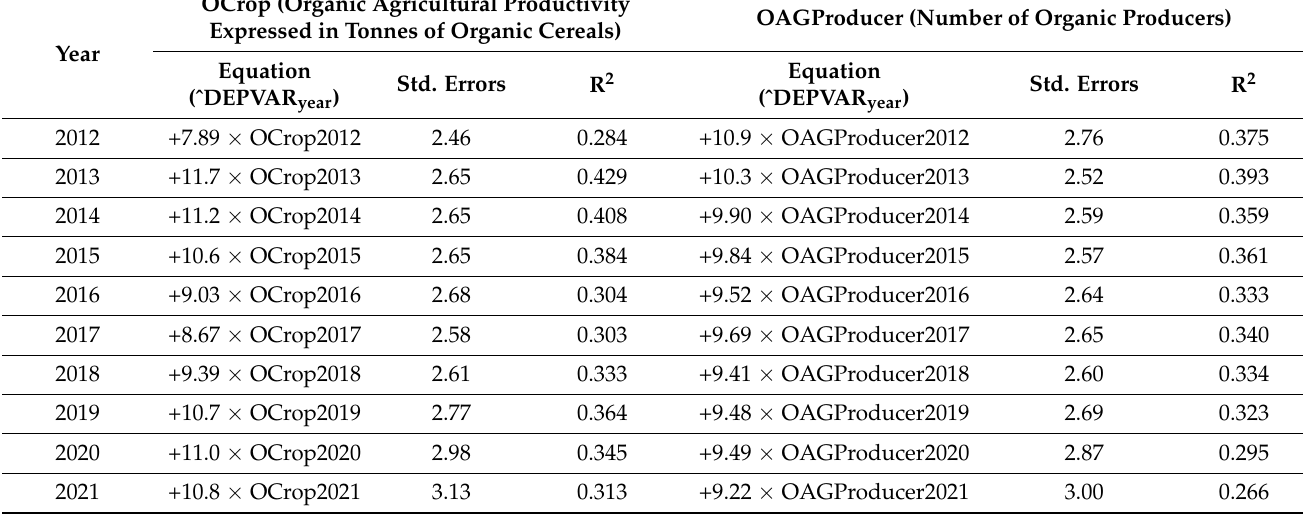
Table 1. Components of the organic productivity function